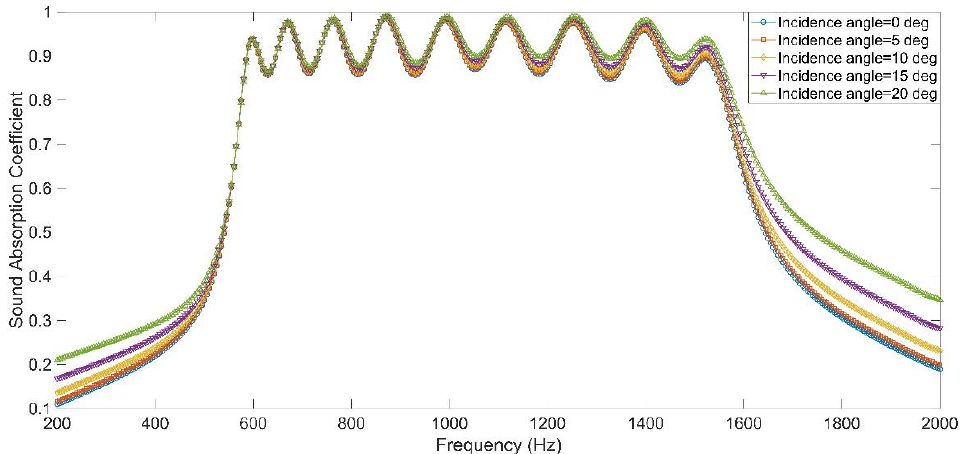
Figure 13. The sound absorption performance of the APH-AM with variable oblique incidence angle obtained in simulation. obtained in